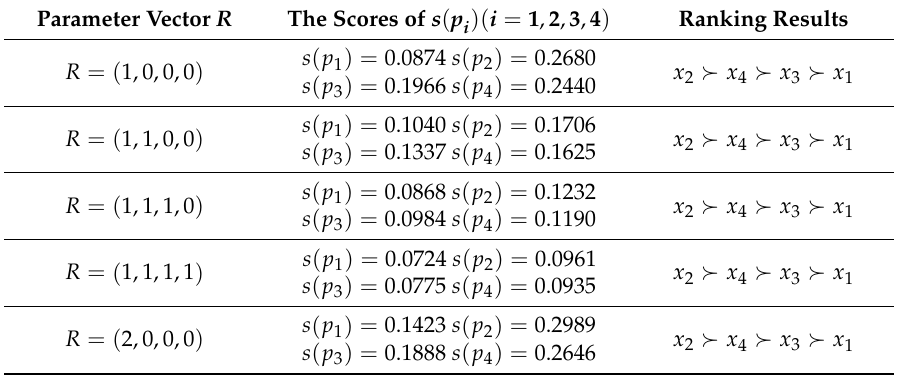
Table 3. Ranking results by utilizing the different parameter vector R in the Pythagorean fuzzy interaction weighted Muirhead mean (PFIWMM)